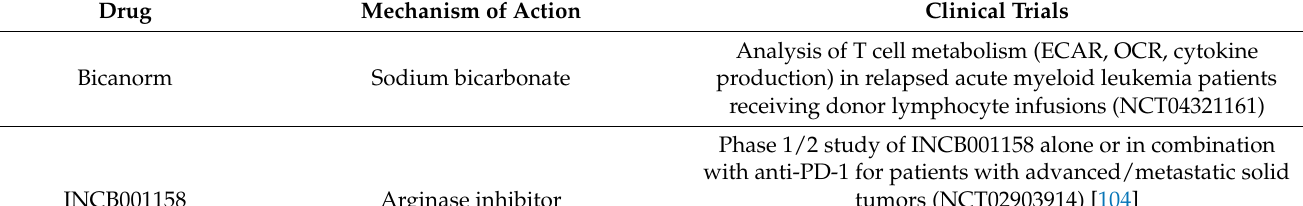
Table 1. A summary of ongoing immunometabolism-targeted clinical trials. ECAR—extracellular acidification rate; KEAP1— kelch-like ECH-associated protein 1; LKB1—serine/threonine kinase 11; NRF2—nuclear factor erythroid 2; OCR—oxygen consumption rate; PD-1—programmed cell death protein 1; TAM—tumor-associated